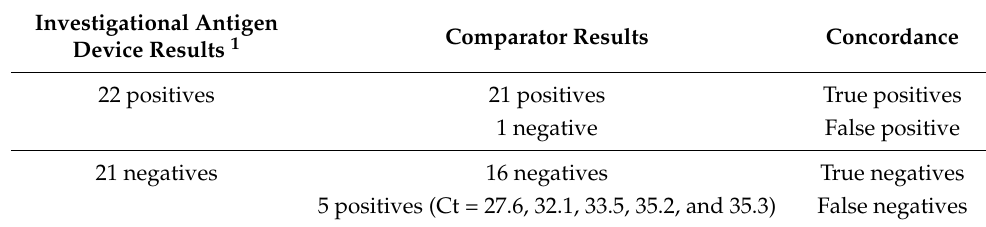
Table 2. Analysis of the 45 subjects with prior known COVID-19 positive diagnostic results 1